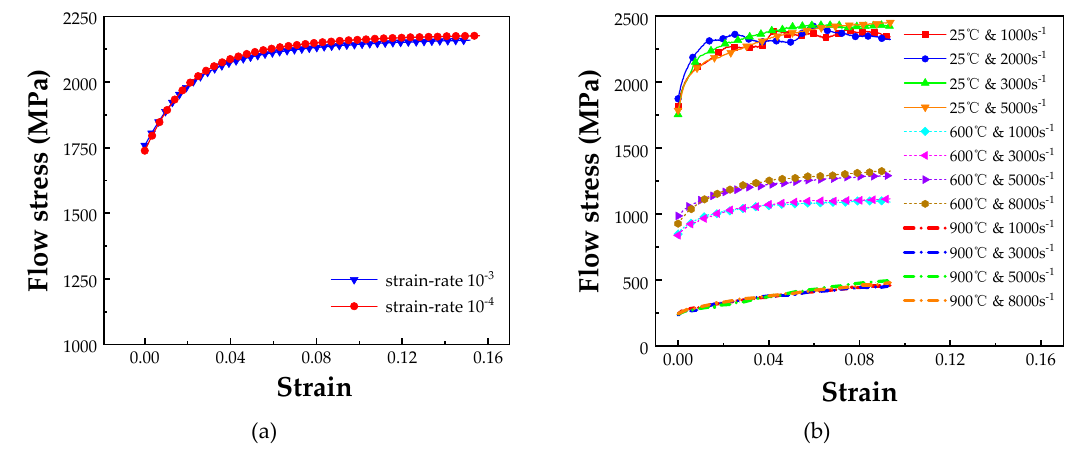
Figure 5. ( a ) Quasi-static and ( b ) SHPB compression test results.